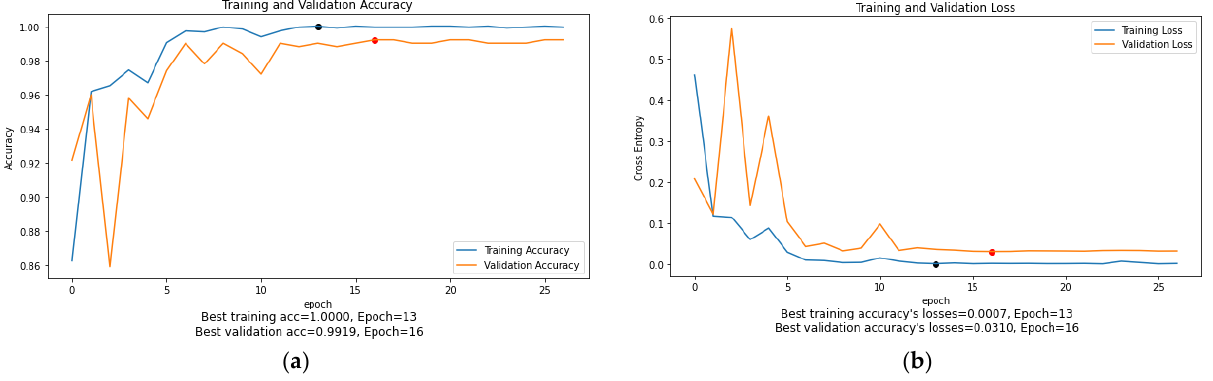
Figure 11. ( a ) Accuracy and ( b ) loss plots throughout the training process of the MobileNet model using the GRAY+GRAY_HE+GRAY_CLAHE image representation.